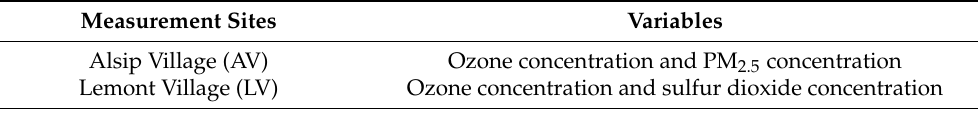
Table 1. Summary of measurement sites and observed variables.